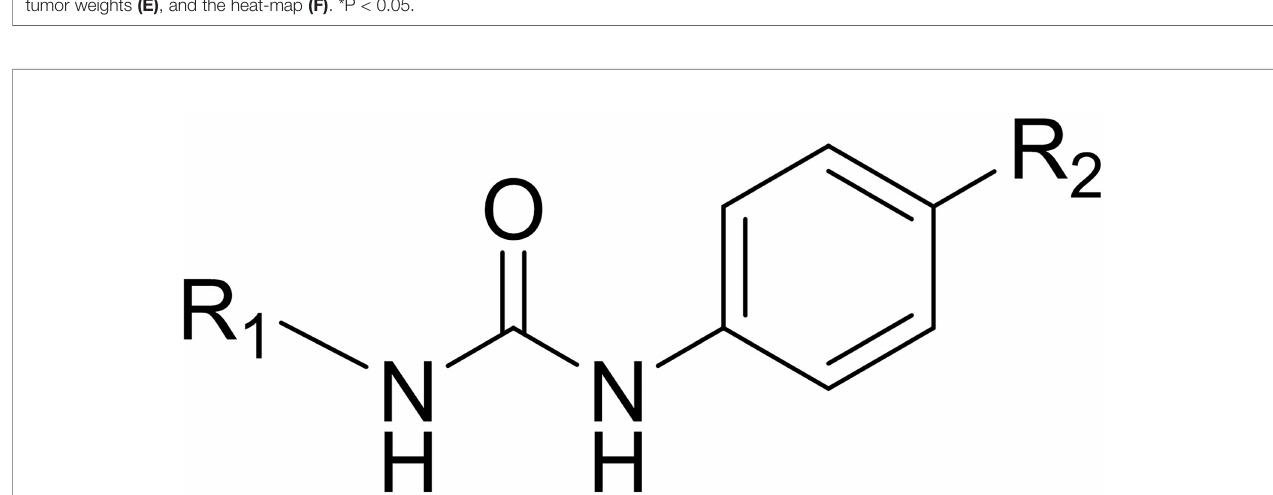
FIGURE 6 | The core structure of SI-1. R1 and R2 refers to the position of the two